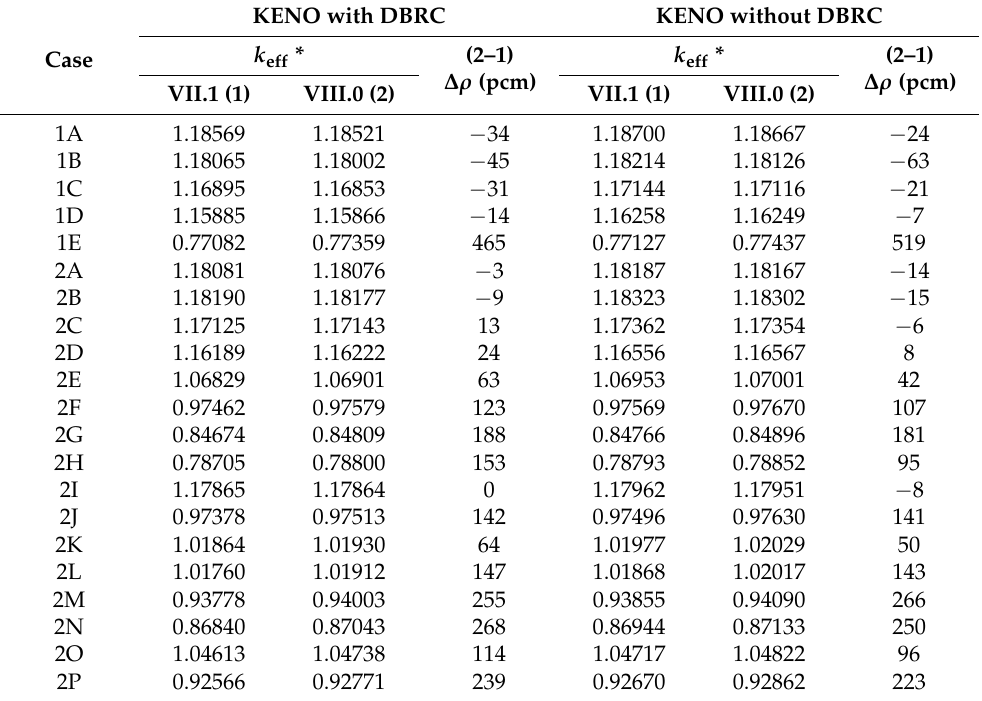
Table 5. Results of the VERA PWR benchmark progression